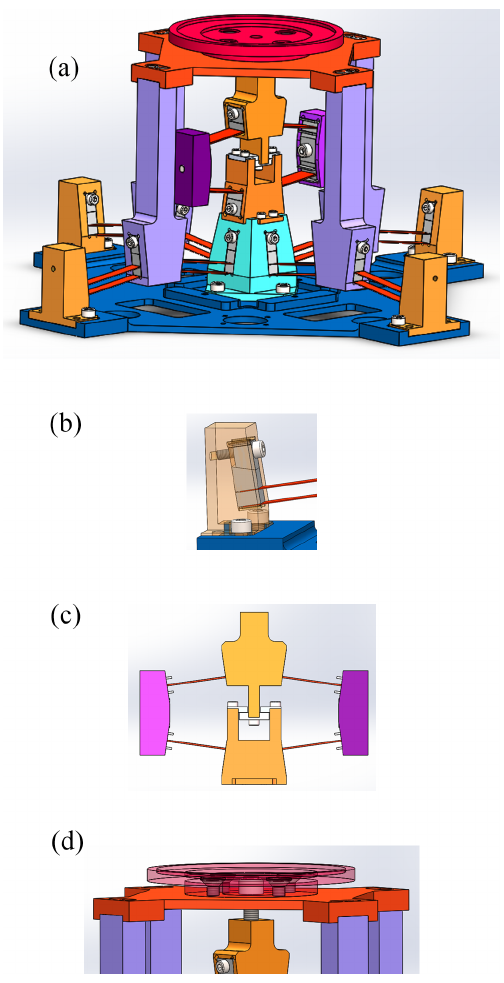
Figure 13. (a) Three-dimensional computer-aided design model of the proposed quasi-zero stiffness mechanism. (b) Leaf springs fully constrained by the wedge-shaped blocks. (c) Limit structure between the moving platform and the fixed base of the positive- stiffness mechanism. (d) The bolt and the limit cover connecting the positive-stiffness and negative-stiffness mechanism